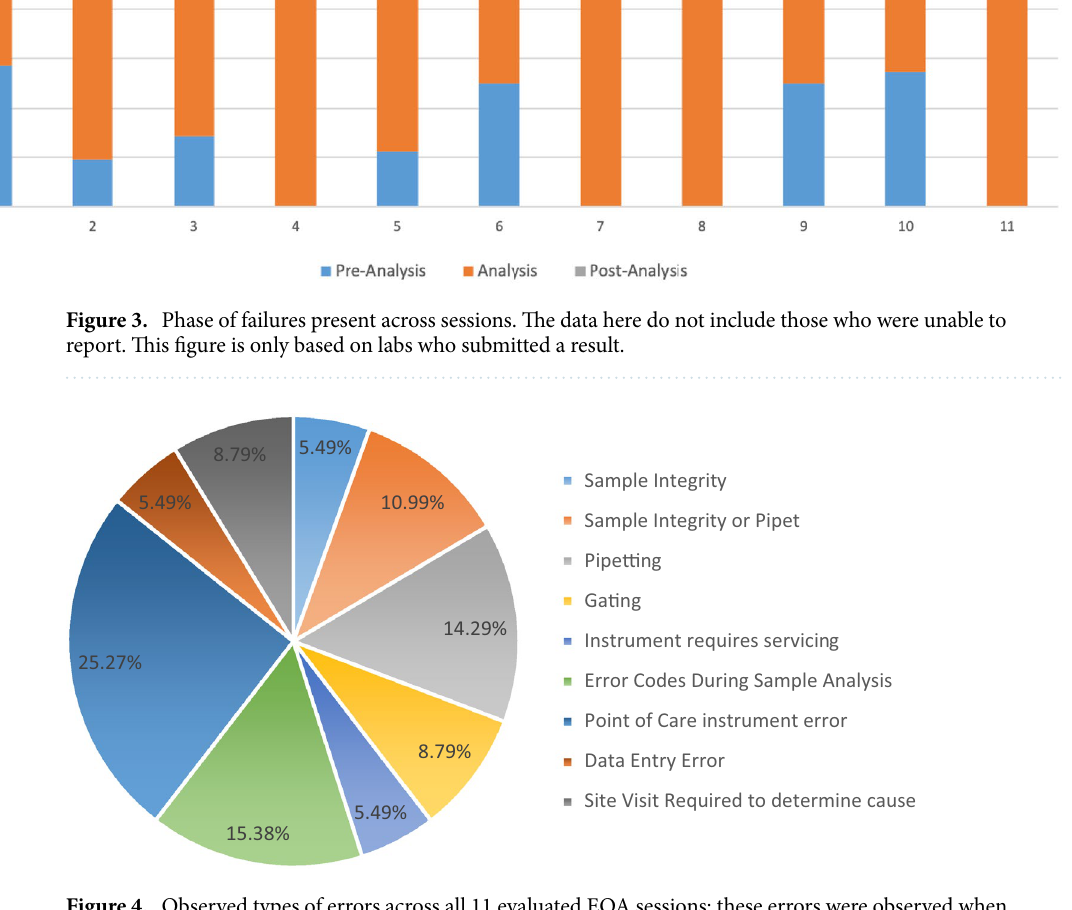
Figure 4. Observed types of errors across all 11 evaluated EQA sessions: these errors were observed when participants returned an incorrect CD4 result whereas errors made by participants who have not returned a CD4 result (unable to report) are